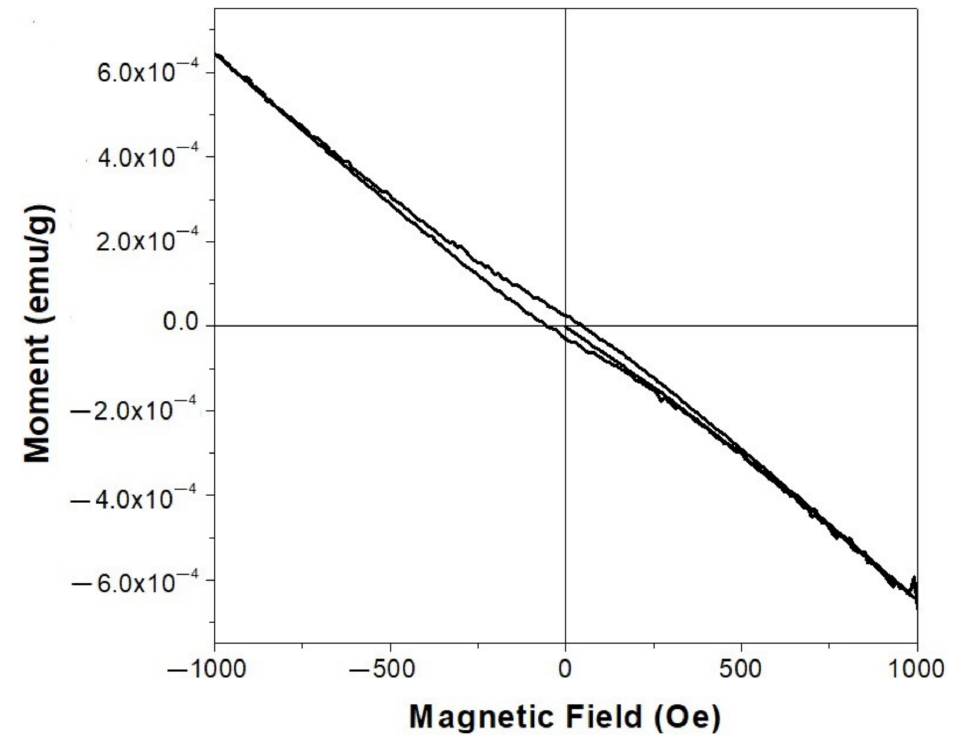
Figure 3. M-H hysteresis loops for sample